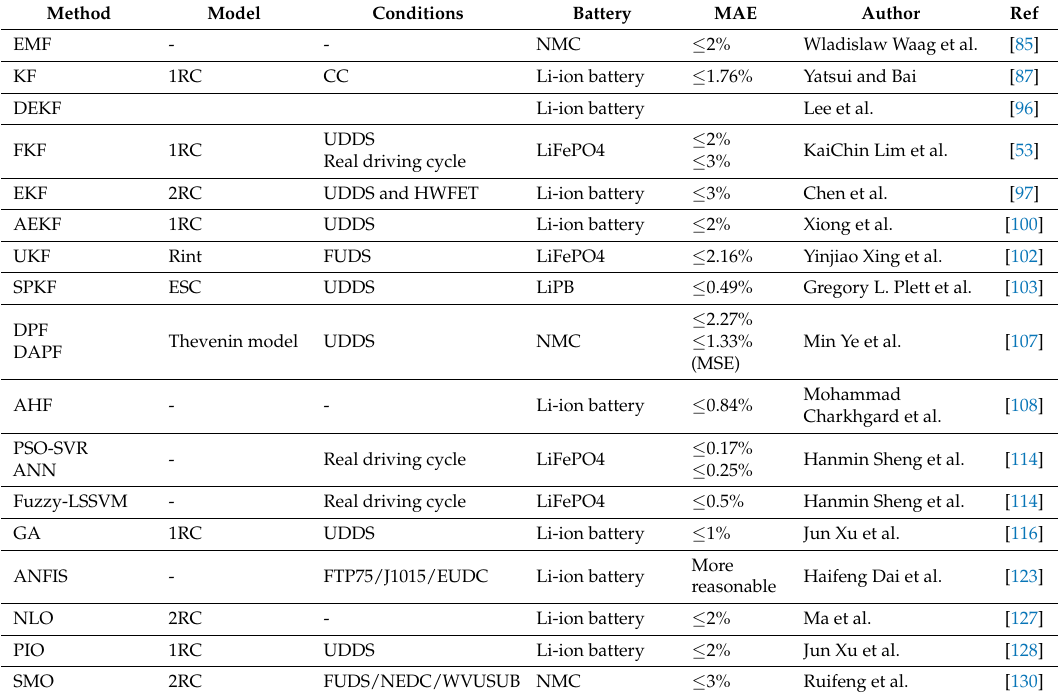
Table 12. Maximum absolute error of different SOC